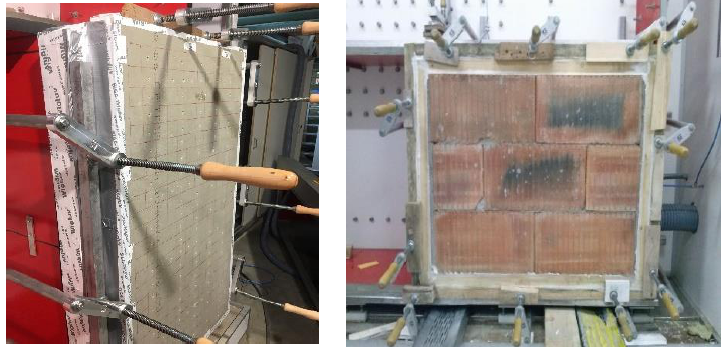
Figure 2. Specimens installed into the air permeability measuring device: drilled wood fiber cement board + insulation in wooden frame (left), and a specimen of ceramic block masonry filled with horizontal joints (right).